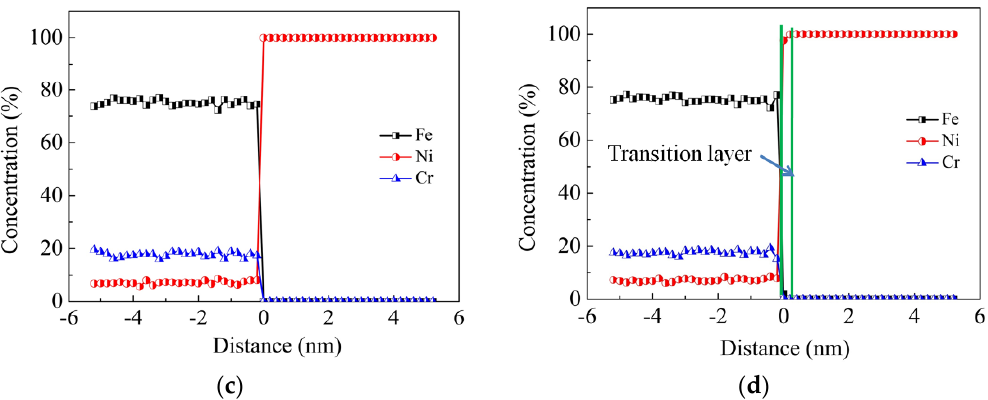
Figure 4. Concentration profiles of Fe, Ni and Cr elements along the vertical direction of interfaces at the temperature of 1200 K and the vertical pressure of 50 MPa: ( a ) Model I at 0 ps; ( b ) Model I at 210 ps; ( c ) Model II at 0 ps; ( d ) Model II at 210 ps.